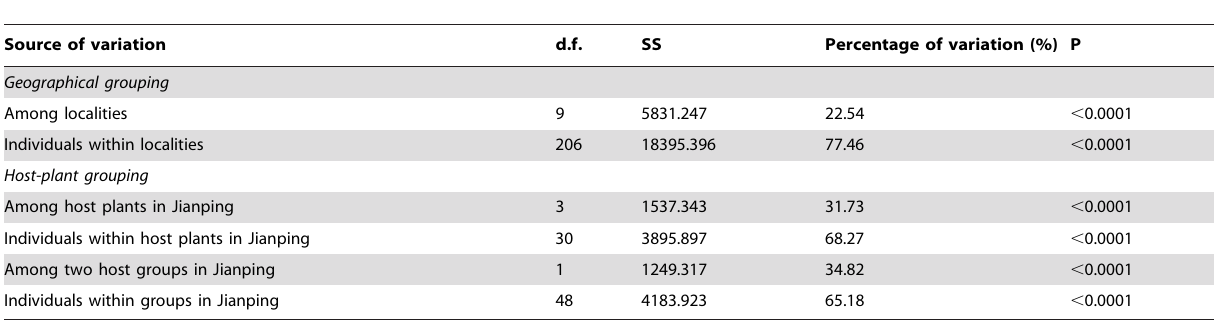
Table 3. Analysis of molecular variance (AMOVA) of H. hippophaecolus populations.